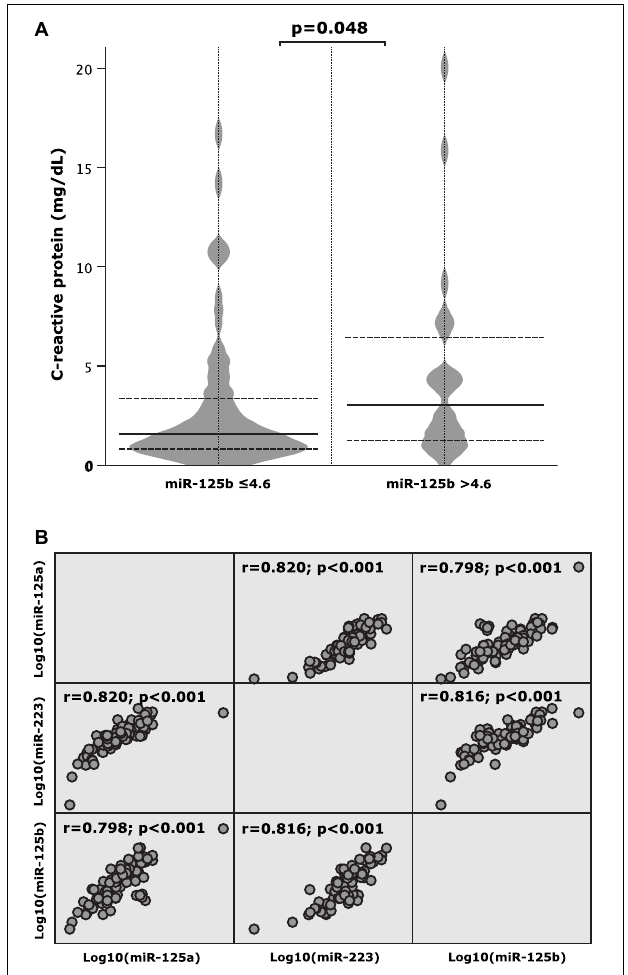
FIGURE 3 | (A) C-reactive protein (CRP) according to high and low values of microRNA (miR)-125b and (B) correlation patterns between miR-125a, miR-125b, and